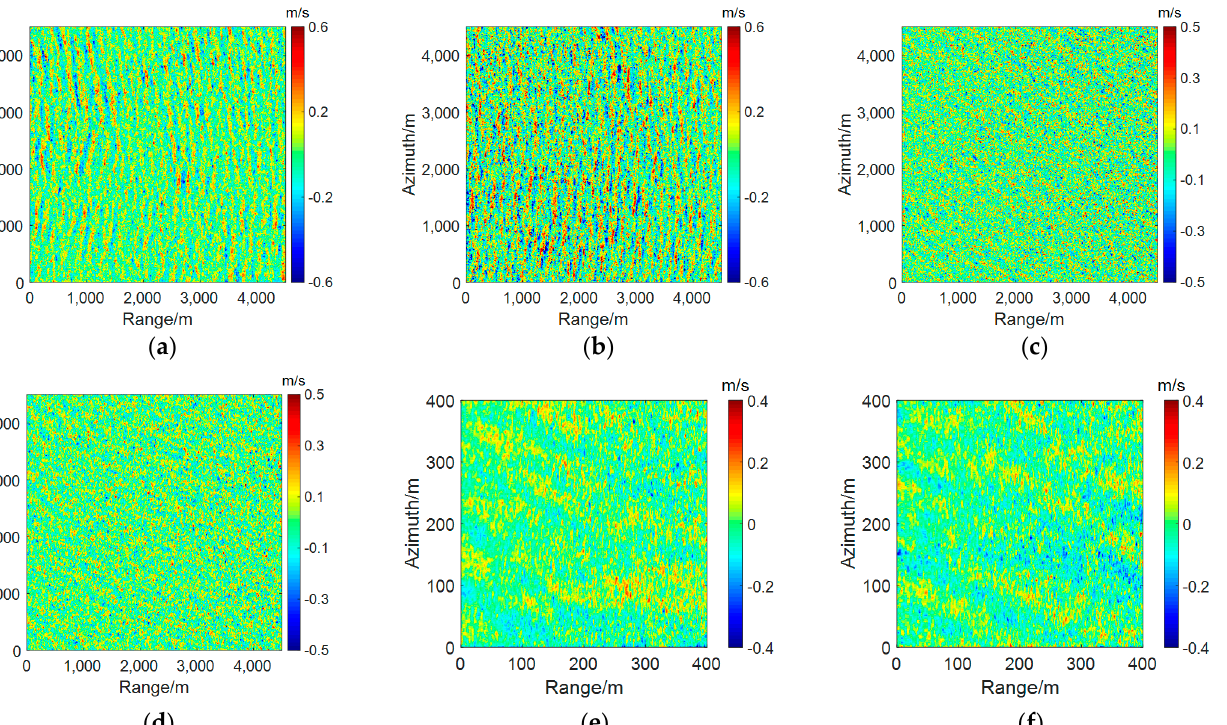
( h ) Figure 12. The spectra of the orbital velocities of ocean waves: A 1 ( a ); A 2 ( b ); A 3 ( c ); A 4 ( d ); M920 ( e ); M3120 ( f ); ( g , h ) one-dimensional spectra orbital velocities of ocean waves retrieved and measured, and the blue lines are the one-dimensional spectra of the orbital velocities retrieved using the air- borne hybrid InSAR system, and the red line is the one-dimensional orbital velocities spectra meas- ured by the GNSS buoy corrected by low-pass filter. 6. Conclusions For the hybrid interferometry systems, which are a combination of along-track and cross-track configurations, we presented a new method for retrieving ocean wave infor- mation such as the sea surface profile and the orbital velocity of ocean waves. This method was derived on the basis of the linear modulation theory in which the sea surface profile V e l o c i t y s pe c t r u m / d BV e l o c i t y s pe c t r u m / d B